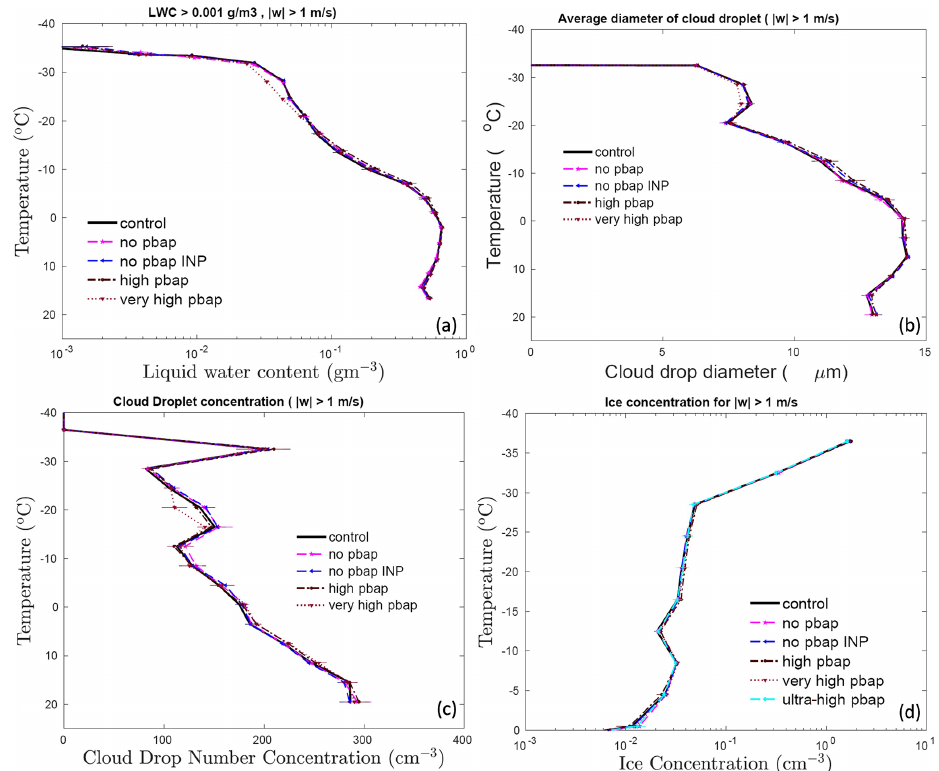
Figure 6. The temperature dependence of the (a) liquid water content, the (b) cloud droplet number, (c) the cloud droplet diameter, and the (d) total ice number concentration for control simulation and various sensitivity runs involving a change in total PBAP number concentrations for the convective region. The averaging conditions are mentioned at the top of each figure. The ice number concentration from the ultra-high PBAP is also shown in panel (d) . All the vertical profiles shown here are averaged for the whole